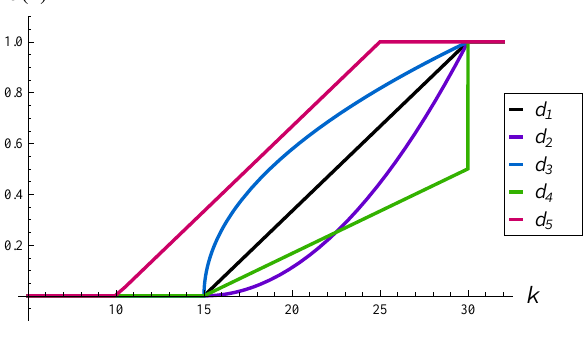
Figure 1. Functions d 1 – d 5